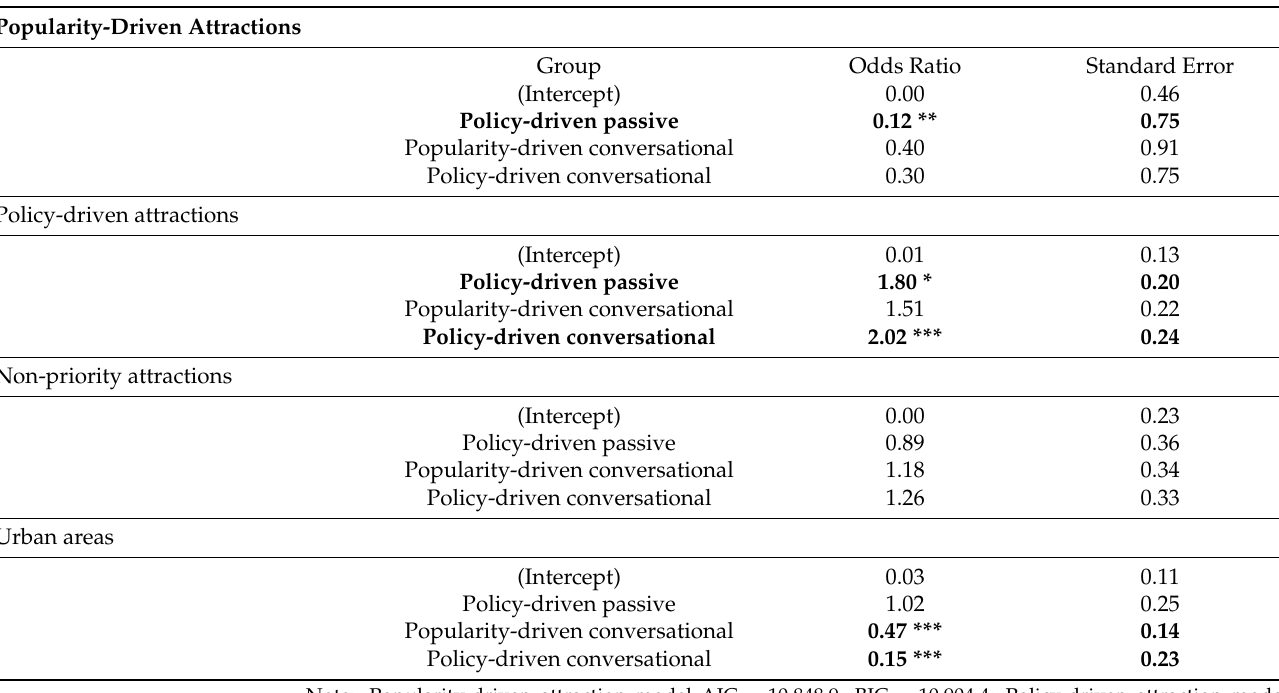
Table 3. Effect of recommender systems and destination information on spatial movement, expressed as odds ratios in reference to popularity-driven passive group.